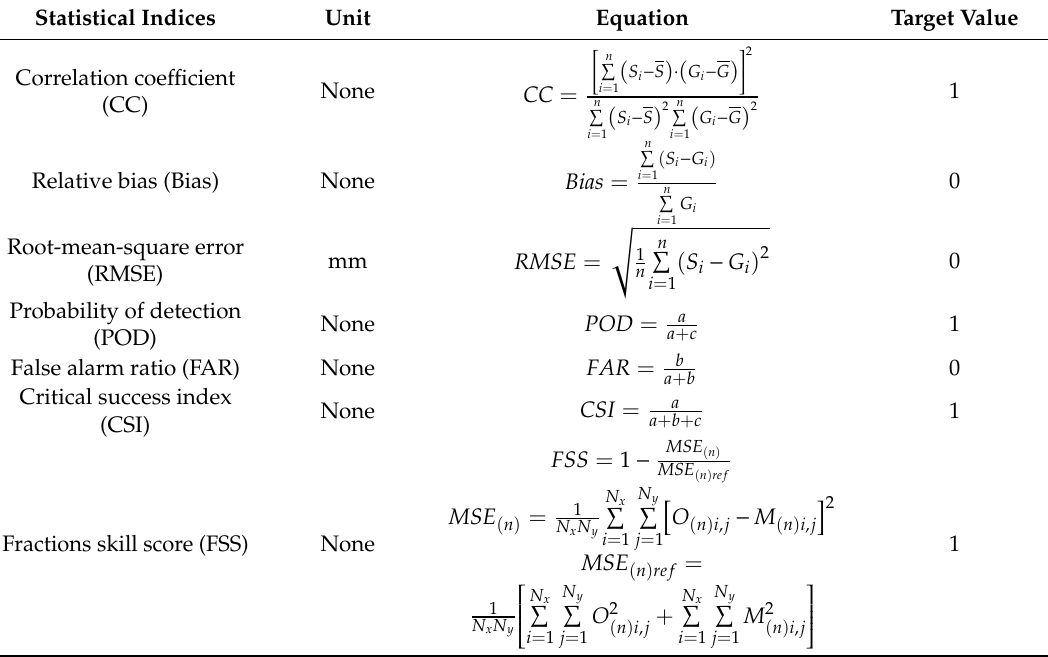
Table 3. Statistical indices for evaluating IMERG and WRF